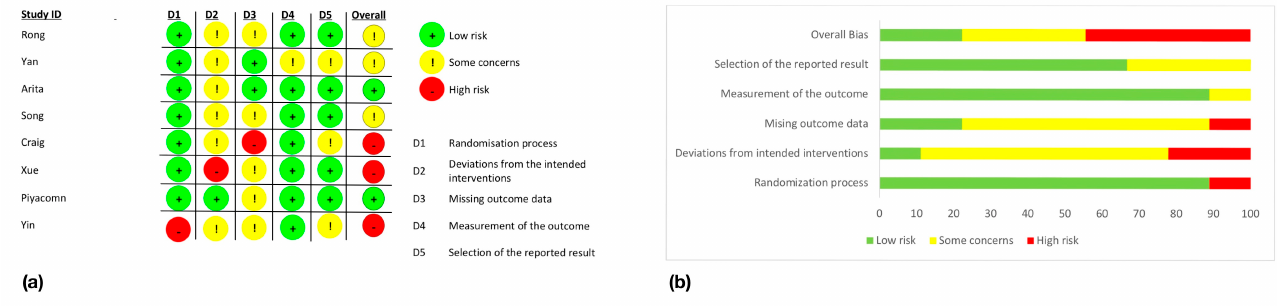
Figure 2. Risk of bias assessment: ( a ) Evaluation of individual studies; ( b ) Overall amount of each bias [12,29–38]. bias